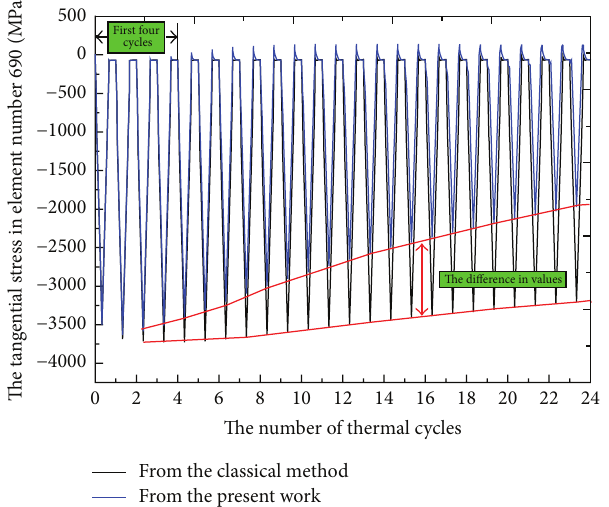
Figure 12: The variation of tangential stress over number 690 element against number of thermal